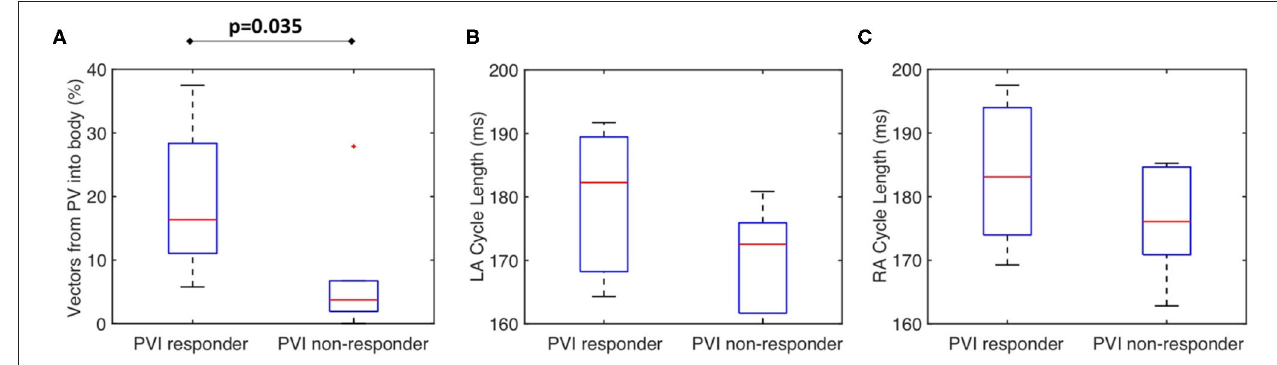
FIGURE 8 | The clinical PV activation flow metric is significantly different for PVI responder and non-responder cases. (A) Clinical PV activation flow (%) pre-ablation was significantly higher for PVI responder than PVI non-responder cases (PVI responder: 16.3% vs. non-responder: 3.71%, p = 0.035). (B) LA cycle length was not significantly different between groups (Wilcoxon signed-rank). (C) RA cycle length was not significantly different between groups.